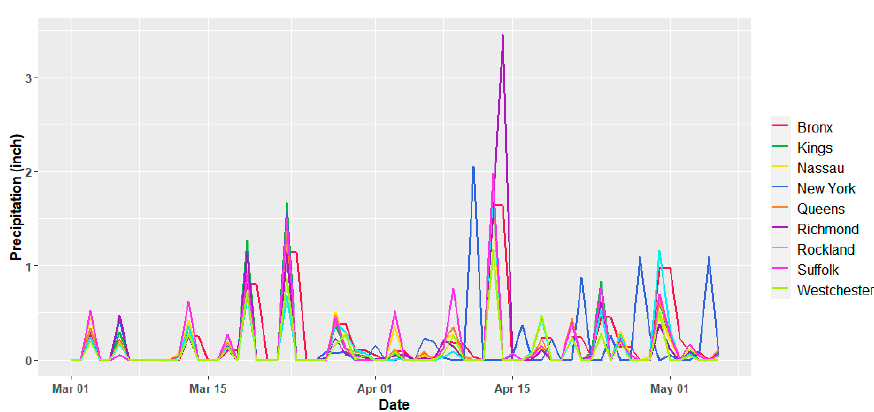
Figure A2. Variation of daily average precipitation for individual counties.